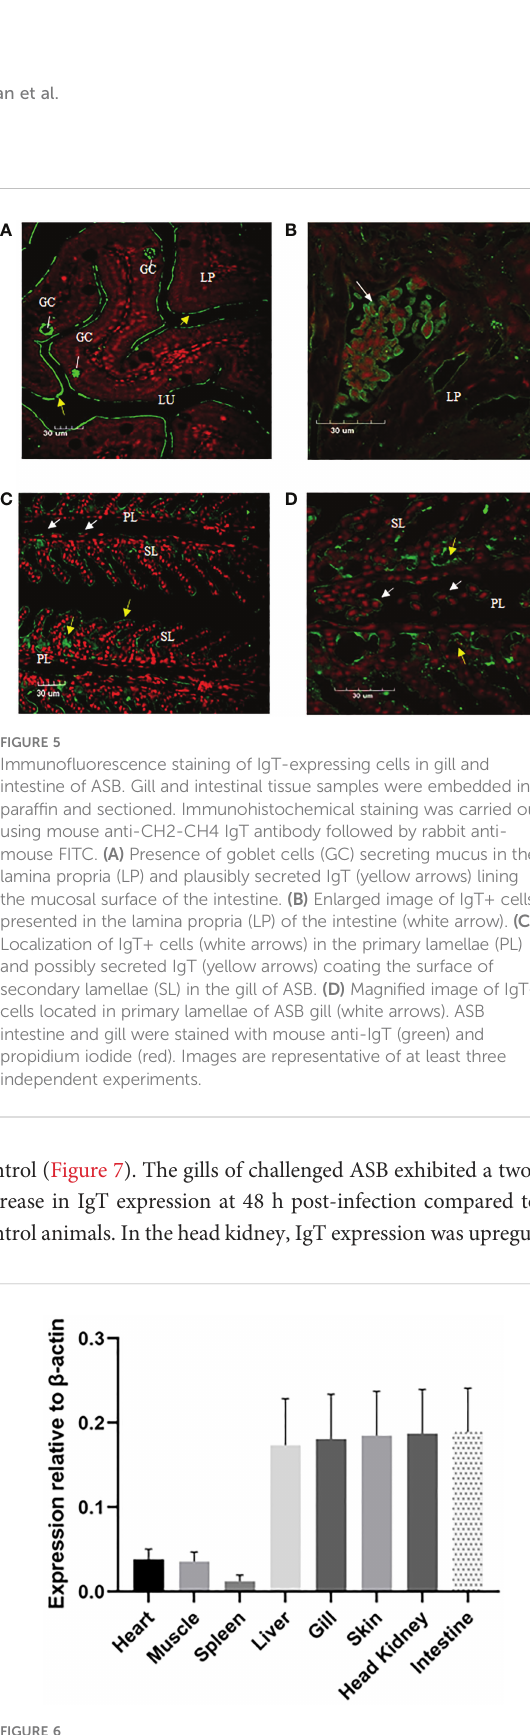
FIGURE 6 Relative expression of IgT in ASB tissues. Basal IgT mRNA expression in eight ASB tissues (heart, muscle, spleen, liver, gill, skin, head kidney and intestine). Total RNA from various tissues of six ASB was individually isolated and transcribed into cDNA. IgT expression was detected using real-time PCR and ASB IgT-speci fi c primers. The IgT mRNA expression level was normalized to transcripts of b -actin and expressed as the mean ± SE.